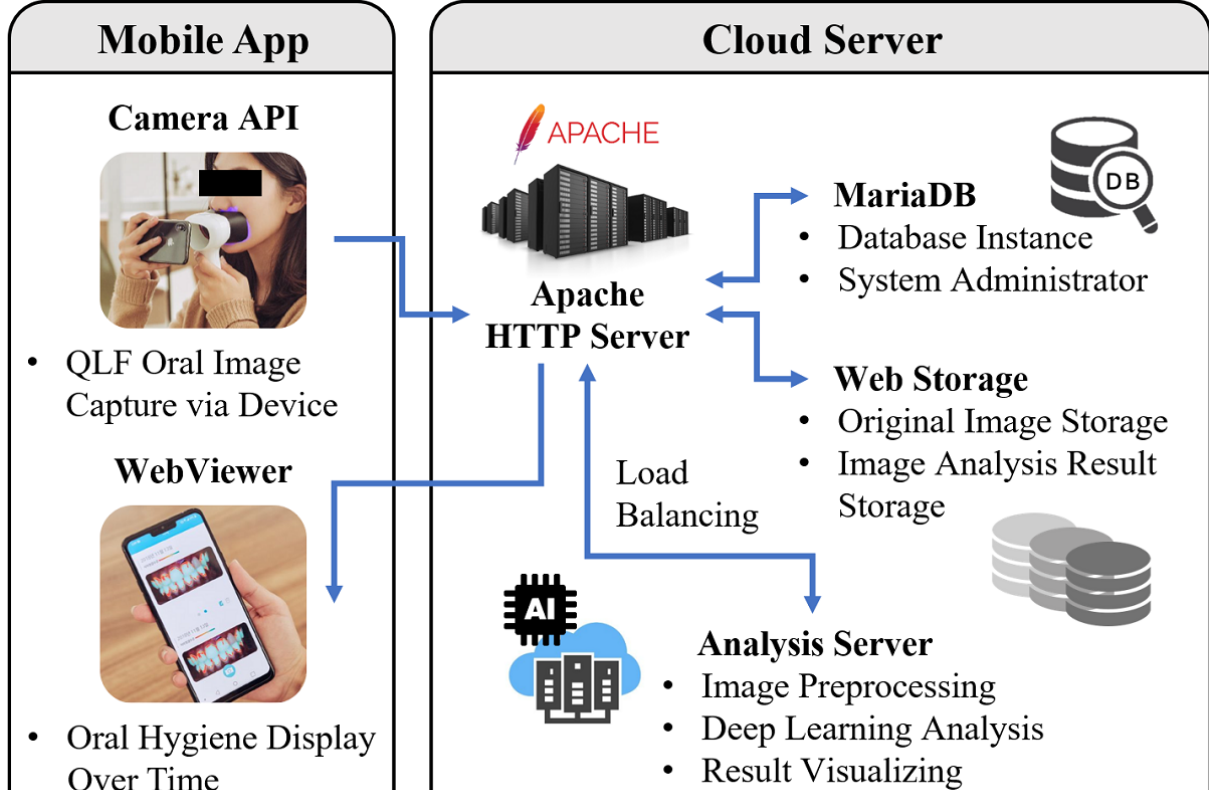
Figure 3. Architecture of the hybrid mobile app comprising mobile app and cloud